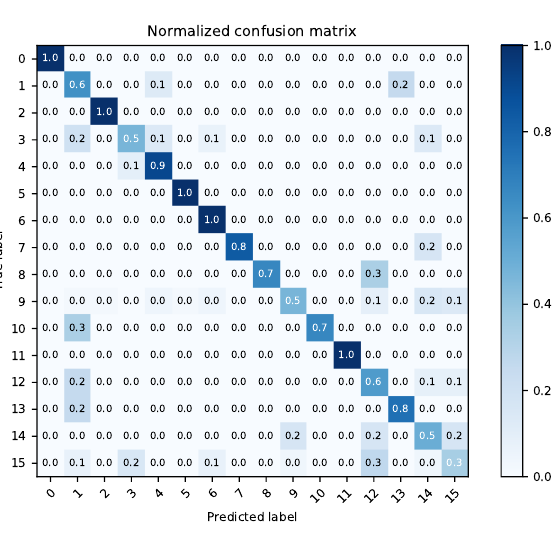
the Dam Classification Task.